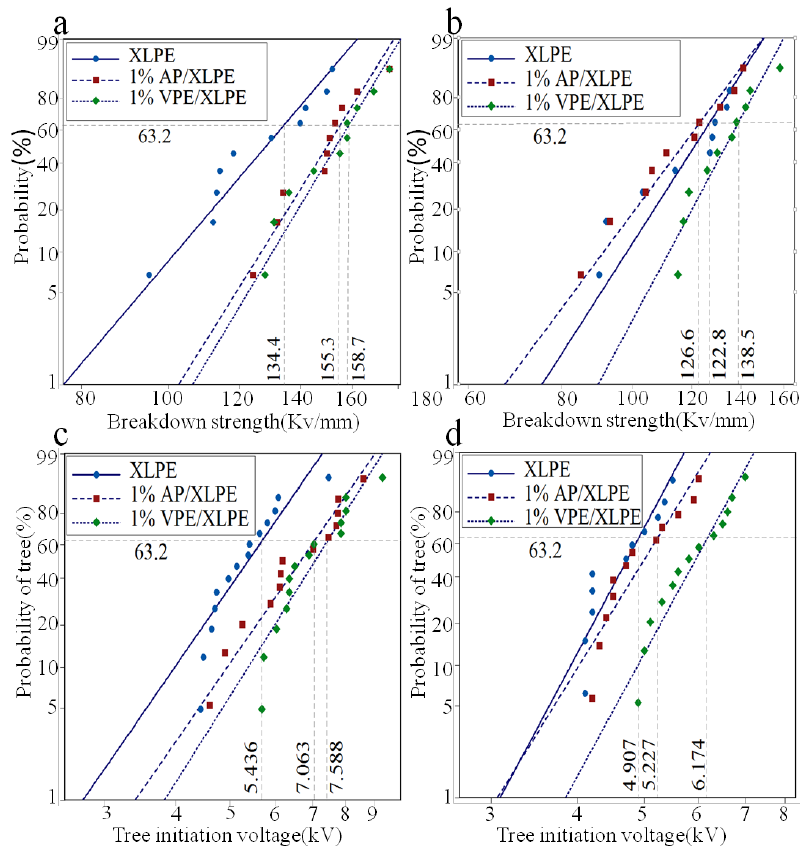
Figure 4. ( a ) breakdown strength of Thermal aging before; ( b ) breakdown strength of Thermal aging after; ( c ) electrical tree initiation voltage of Thermal aging before; ( d ) electrical tree initiation voltage of Thermal aging after. Table 3. AC breakdown strength of different samples of Thermal aging before and after.